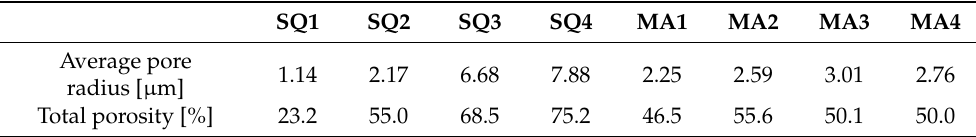
Table 2. Mercury porosimetry results of sintered